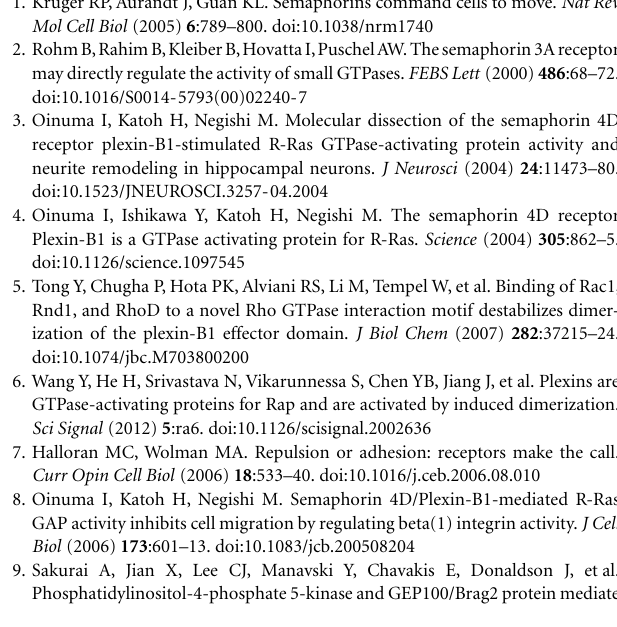
with wt ( P < 0.005) as was the medullary ER-TR5 representation ( P < 0.02). Mean ± SEM presented and compared using Student’s t -test. Figure S5 | Co-localization of ESAM + blood vessels and UEA1 + mTEC in thymi of Tcrb + / + Rag2 − / − mice injected with anti-CD3 ε mAb . Adjacent cryosections of each thymus were stained with the indicated Abs. anti-ESAM was used to visualize endothelial cells and UEA1 to visualize mTEC.The corticomedullary junction is indicated by the dashed line.The result represents two independent analyses.White bar in the ESAM panels is 100 µ m and applies to all panels. Figure S6 | ESAM + blood vessel distribution is normal in D1ThyCKO mice . The thymic cryosections of the indicated mice were stained as described in Figure 5C .The result is representative of three independent experiments.The dashed line follows the corticomedullary junction where the demarcation between cortex and medulla is based on the location of DP and SP thymocytes, respectively. ESAM is an endothelial cell-specific marker.White bar in merged image is 100 µ m. C, cortex; M, medulla. Figure S7 | Normal CD69 + thymocyte distribution in transplanted D1EnCKO mice . Adjacent cryosections of D1EnCKO thymi transplanted under the B6.SJL renal kidney capsule were stained as described for Figure 2 and Figure S3.The cortex (C) and the medulla (M) were divided based on the location of DP and SP thymocytes.The left dashed line in each section follows the corticomedullary junction and the right dashed line depicts the thymic capsule.White bar in merged images is 100 µ m.The figure is representative of two independent experiments.The graph depicts the enumeration of CD69 + cell density using the FITC signal intensity as described in Figure 3 . Sections from three independent thymi were analyzed for each genotype (wt and D1EnCKO) and P values were calculated using Student’s t -test where the ordinate axis depicts the ratio of CD69 + cells in the medulla to CD69 + cells in the cortex. Error bars represent SEM.The P value of 0.34 is not statistically significant. Figure S8 | Pecam1 + endothelial cells are increased in newborn D1EnCKO mice . (A) were collected fromWT ( n = 2, “ Control ” in figure) and D1EnCKO ( n = 3, “ Mutant ” in figure) newborn mice and fixed overnight in 10% formalin solution, then stained for Pecam1 (CD31). (B) The overall intensity/area was determined by image analysis forWT, and then bothWT and D1EnCKO Pecam1 densities were expressed as a ratio of theWT values. Mean ± SEM is depicted. The white bar, applicable to all panels, represents